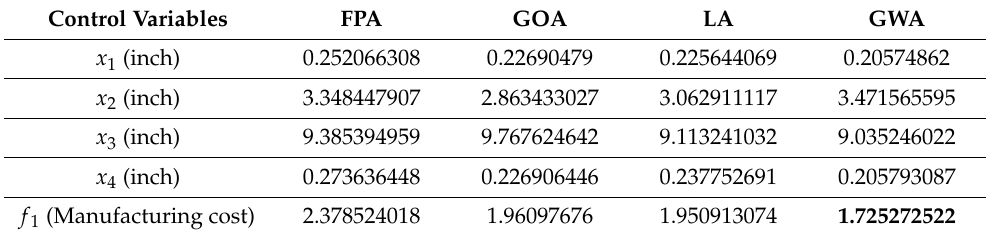
Table 9. Optimal results of the GWA, FPA, LA, and GOA for TLSM design under first case. Control